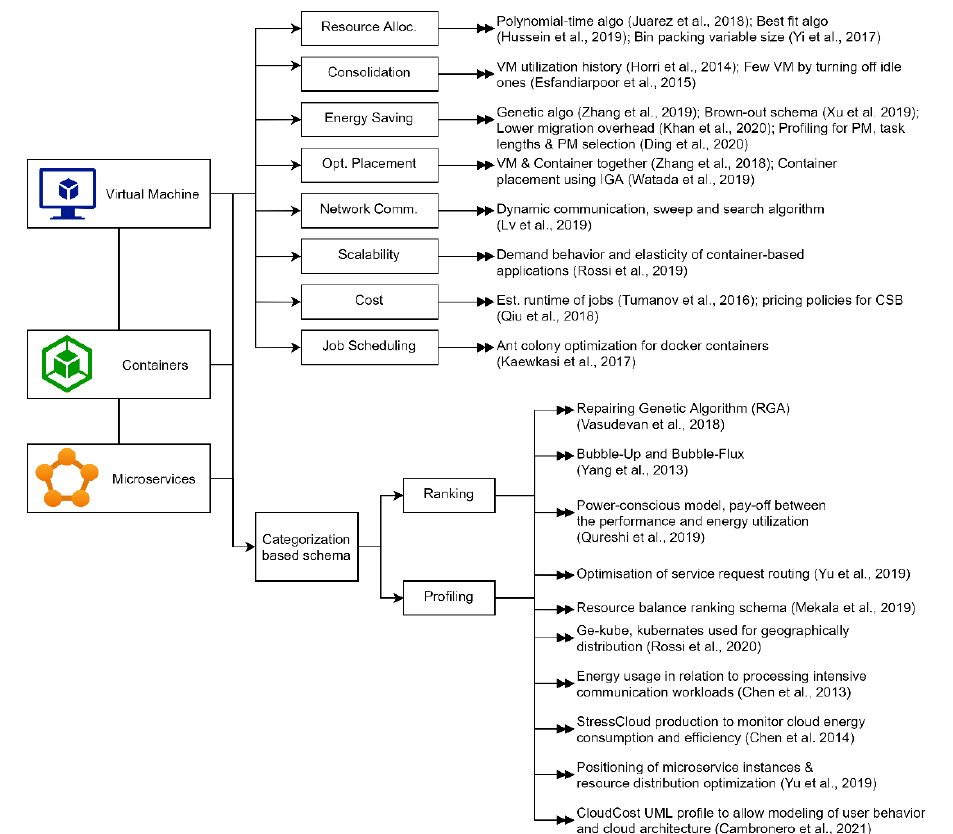
Figure 5. Key findings from the literature review of concepts, theories, and existing frameworks [6 – 15,18 – 20,23,29,33,43 – 51].